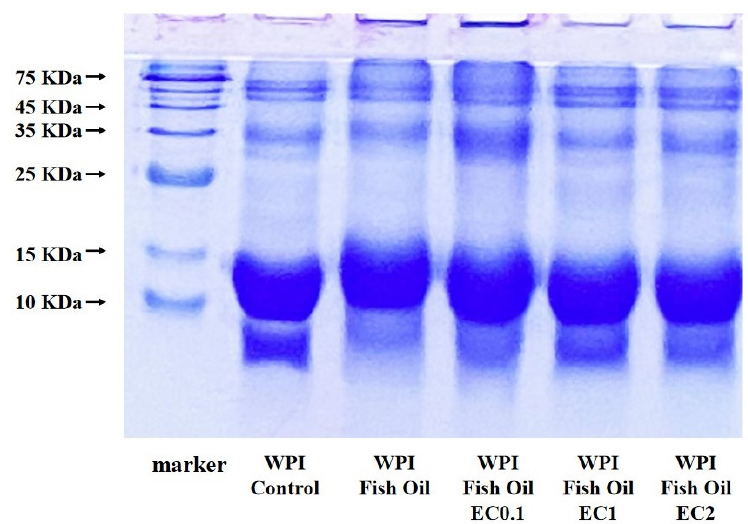
Figure 4. SDS-PAGE analysis of the protein profile of WPI in fish oil-fortified emulsions incubated at 25 °C for 24 h in the absence or presence of EC (0.1~2 mM).